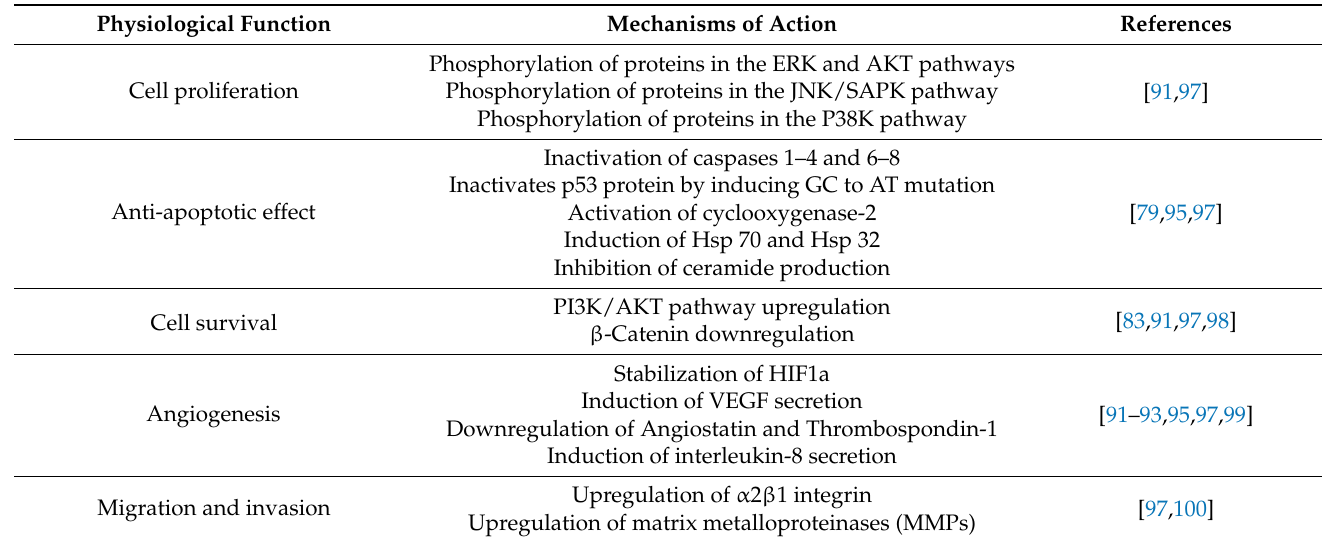
Table 2. Cancer-promoting physiological function of low concentrations of NO.